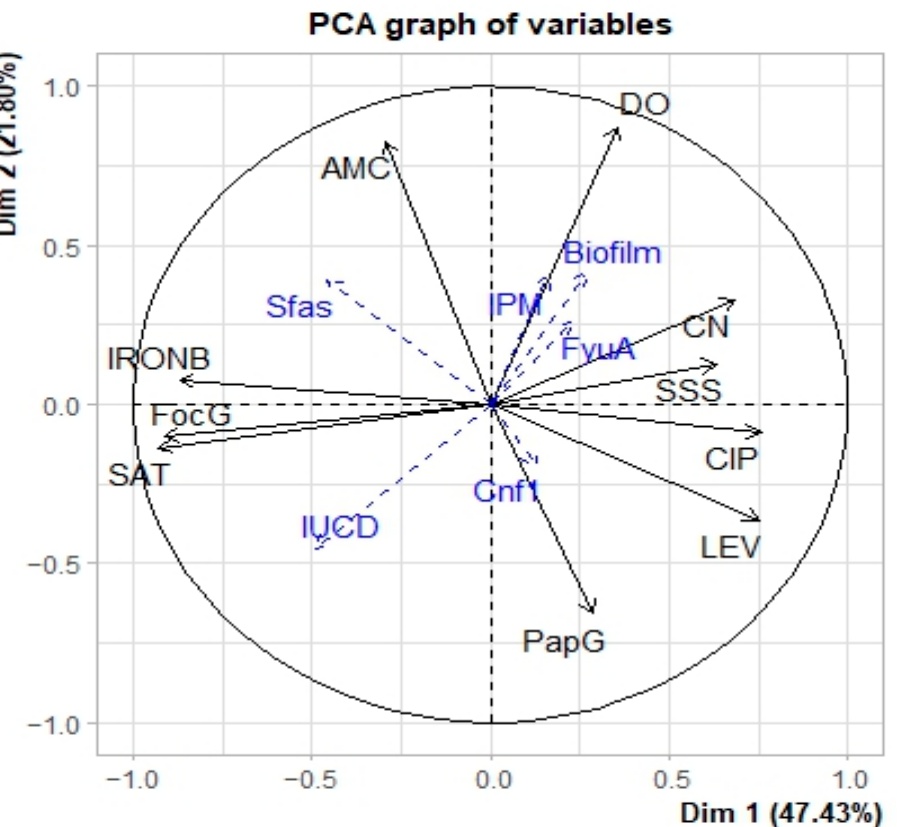
Figure 6. Circle of correlation of variables with the two axes. The projection of the different observations at the level of axes 1 and 2 (Figure 7) indicates that the species E. cloacae , E. sakazakii , K. ornithinolytica , and K. terrigena are mainly located in the positive parts of the two axes. These species are resistant to the antibiotics “DO”, “CN” and “SSS”. C. freundii and S. liquefaciens are mainly located in the positive part of axis 1 and the negative part of axis 2. S. liquefaciens better expresses the virulence gene Pap G. E. intermidius is located in the negative part of the two axes. This species expresses sat and Forc G virulence genes, which were not found in E. cloacae , E. sakazakii , K. ornithinolytica and K. terrigena . The species S. arizonae and S. fonticola are lo- cated in the negative part of axis 1 and the positive part of axis 2. It was noticeable that these species express both the Iron B virulence gene and the AMC resistance gene, in con- trast to the species C. freundii and S. liquefaciens .